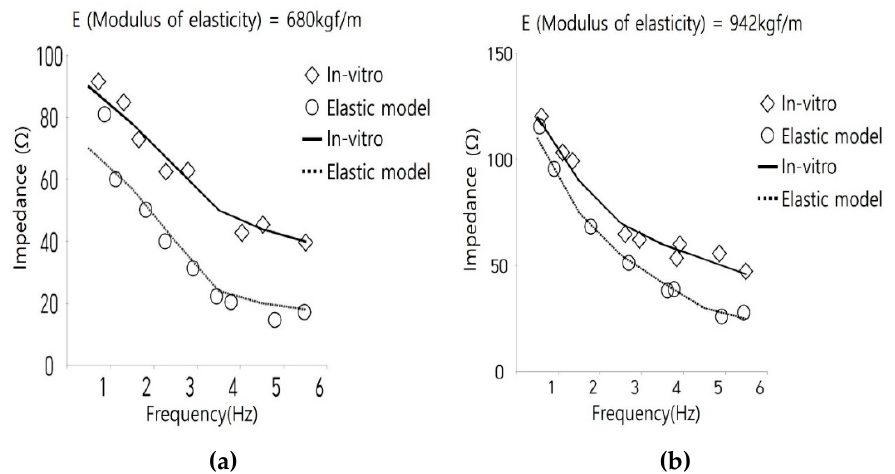
Figure 1. Impedance by elastic factor: ( a ) Modulus of elasticity at 680, ( b ) Modulus of elasticity at 942. Here, frequency indicates the number of CPR compressions, and the change in impedance is sensitive to the CPR cycles and intensity. This can indicate whether the CPR was performed accurately. Based on these changes, we can observe changes in the sternum and thus detect changes in the thoracic impedance